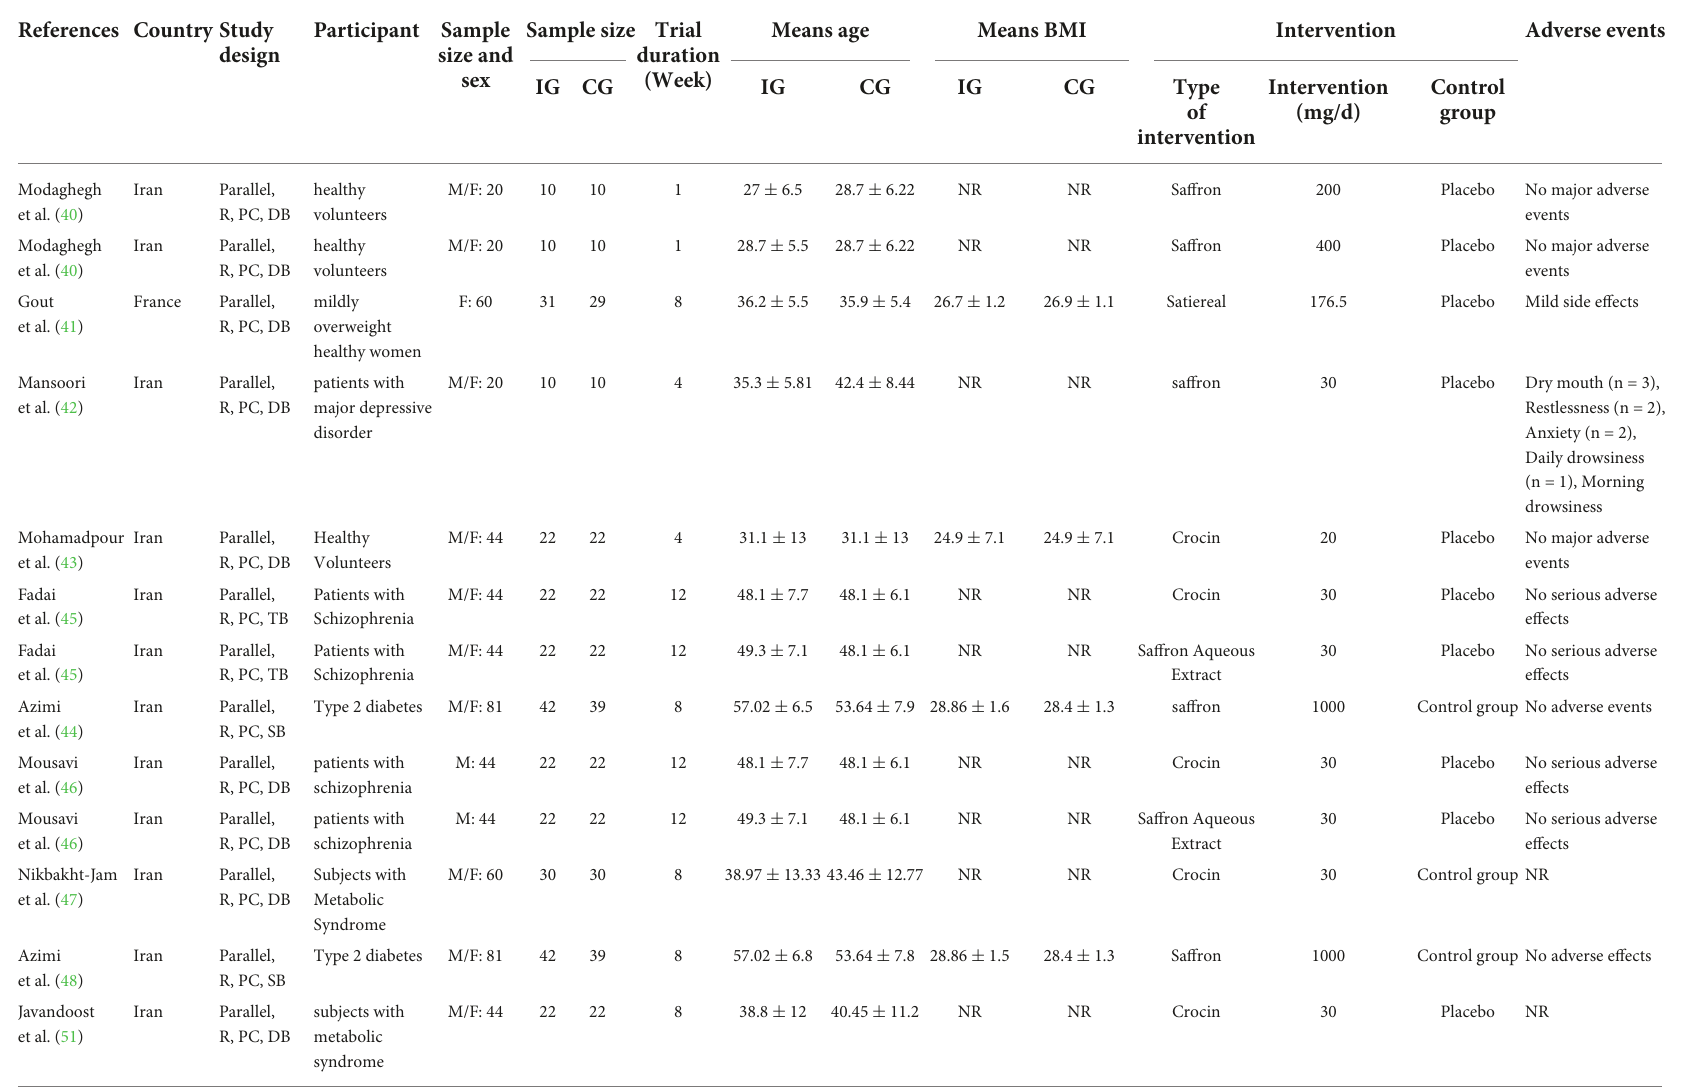
TABLE 1 Characteristics of included studies in the